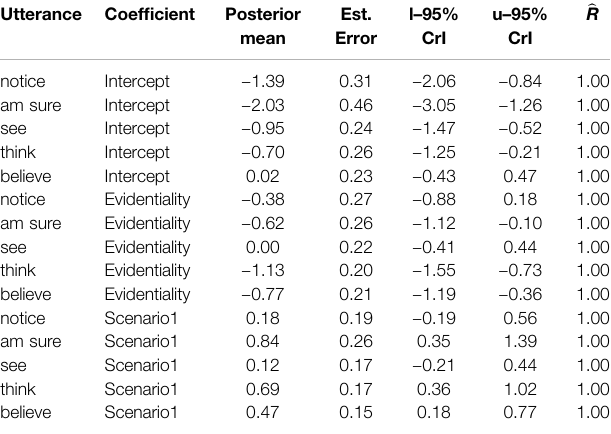
TABLE 3 | Population-level estimates of the categorical regression model in log- odds with the standard errors and 95% credible intervals. Utterance Coef fi